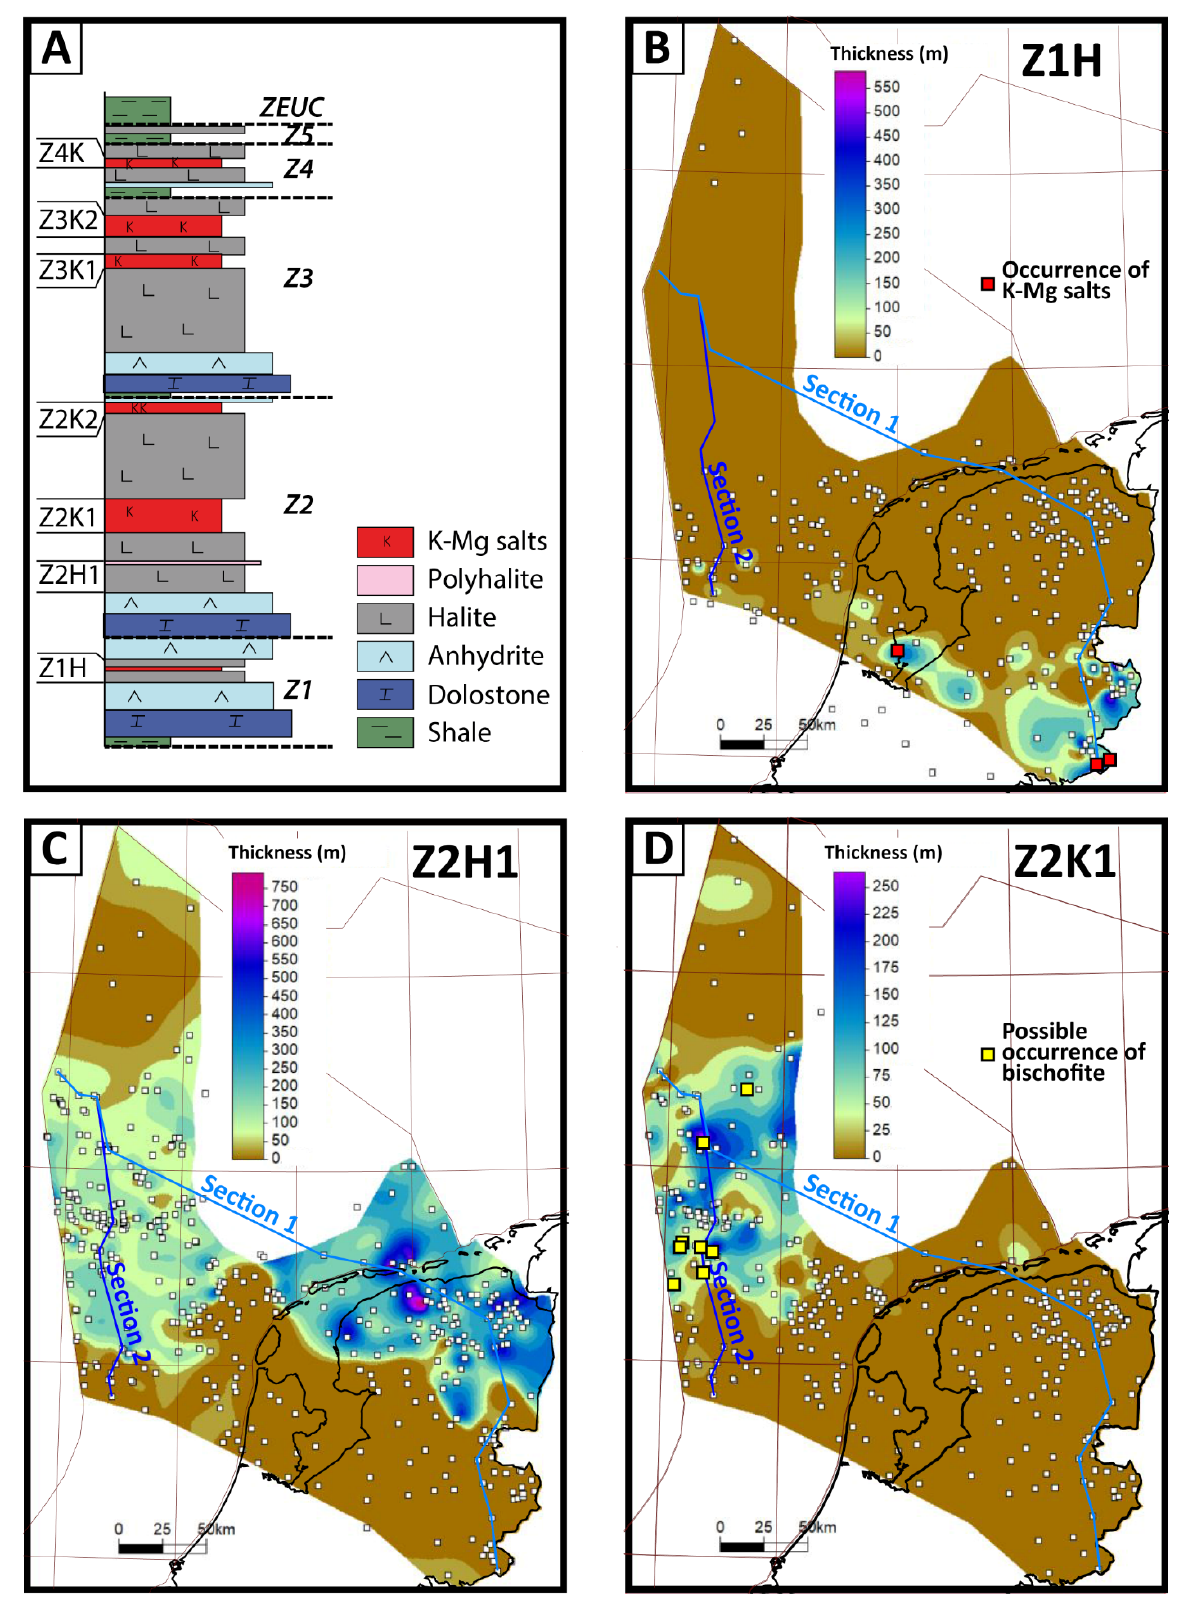
Figure 5. ( A ): Composite lithologic log of the Zechstein group with the identification of the subunits for which the isopach maps are illustrated in ( B – D ) and in Figure 6.